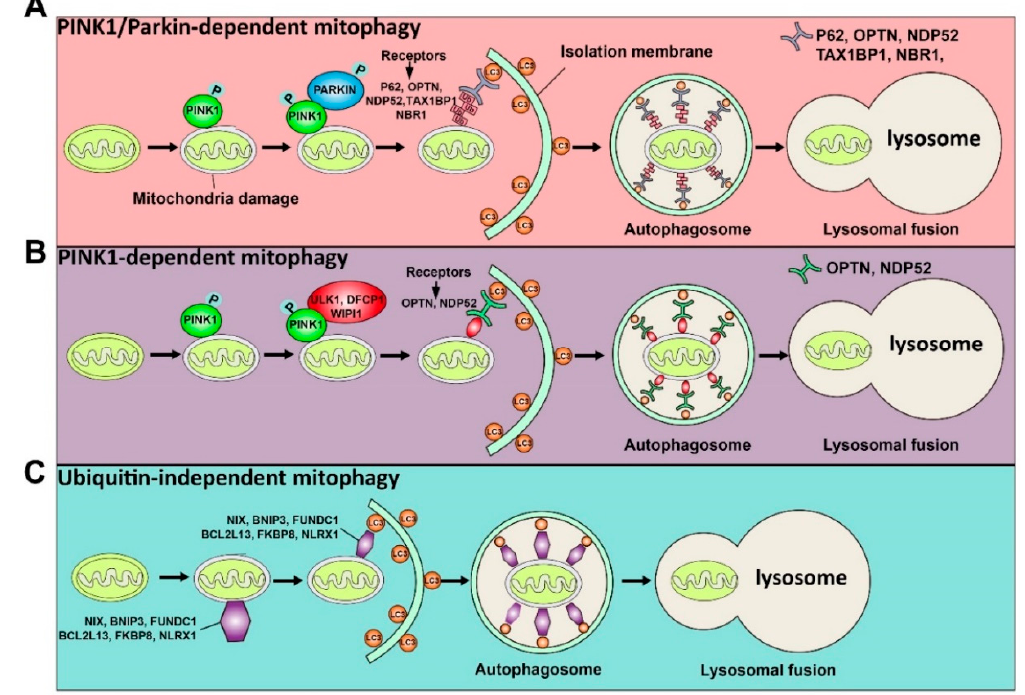
Figure 1. Schematic illustration of the ubiquitin-dependent and ubiquitin-independent pathways of mitophagy is shown. The ubiquitin-dependent mitophagy can be divided into PINK1 / Parkin-dependent mitophagy ( A ) and PINK1-dependent mitophagy ( B ). ( A ) Once mitochondria are damaged, PINK1 will accumulate on the OMM (outer mitochondrial membrane) and activate it by phosphorylation. The activated PINK1 recruits and activates PARKIN by phosphorylation. Then, the activated PARKIN produces the polyubiquitin chains recognized by receptors (P62, OPTN, NDP52, TAX1BP1, and NBR1). These receptors will bind with the LC3 adaptor to engulf mitochondria to complete autophagy. ( B ) The activated PINK1 recruits ULK1, DFCP1, and WIPI1, which can be recognized by receptors (OPTN and NDP52) to induce PINK1-dependent mitophagy. ( C ) Some proteins, including NIX, BNIP3, FUNDC1, BCL2L13, FKBP8, and NLRX1, can directly recognize the LC3 adaptor and initiate the mitophagy process.